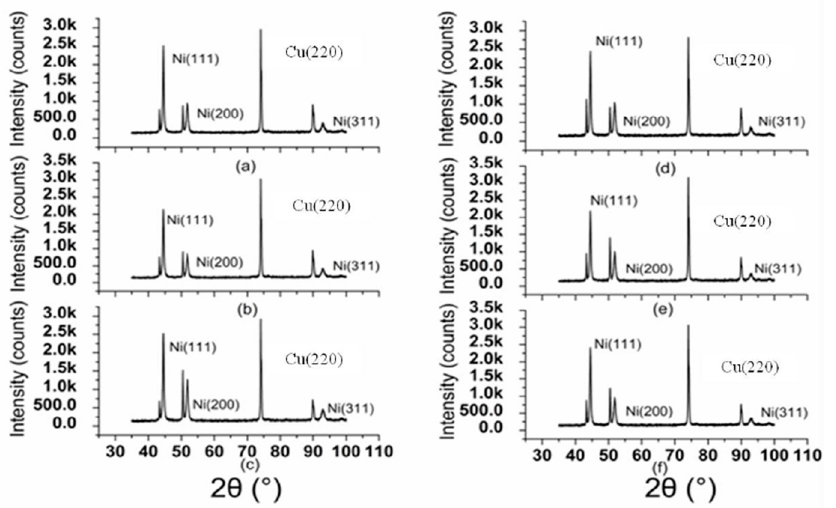
Figure 7. XRD pattern of the electroplated Ni coating: ( a ) 200 W; ( b ) 100 W; ( c ) 0 W; ( d ) 200 kHz; ( e ) 120 kHz; ( f ) 80 kHz.